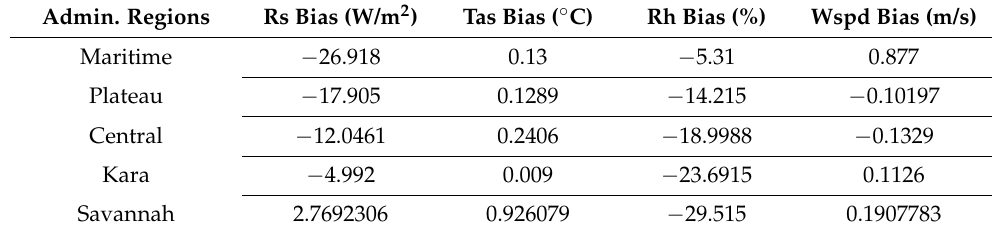
Table 4. Variables biases—Simulations vs. Observation. Admin. Regions